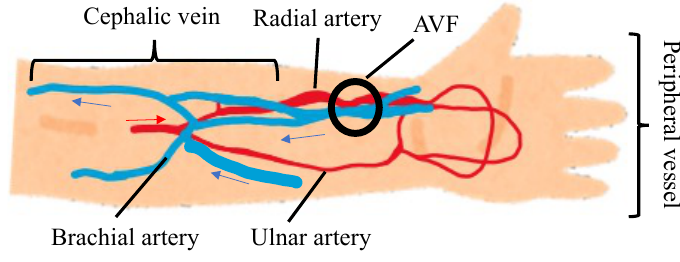
Figure 18. Mechanism of blood flow in cephalic